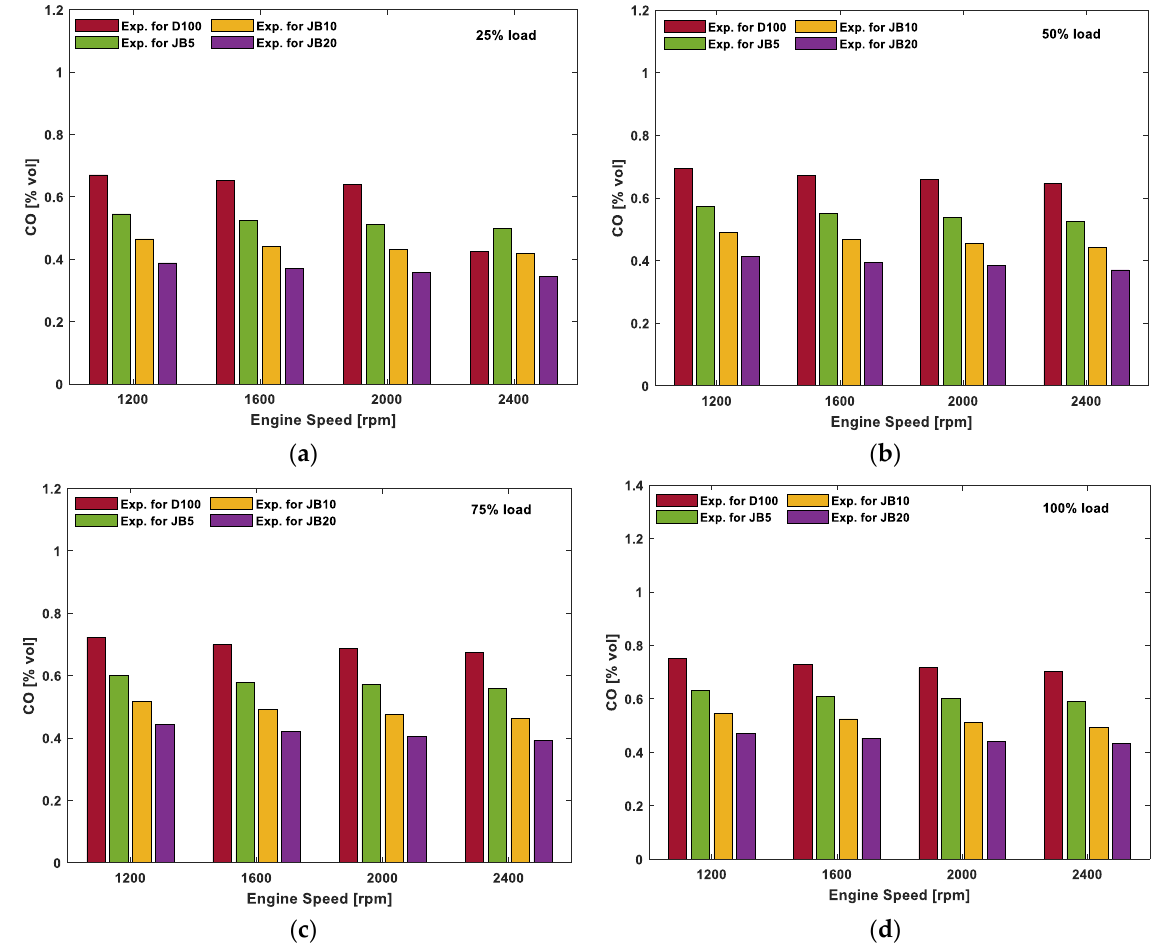
Figure 9. Variation in CO with engine speeds for D100, JB5, JB10, and JB20 at ( a ) 25%, ( b ) 50%, ( c ) 75%, and ( d ) 100% loading operation.